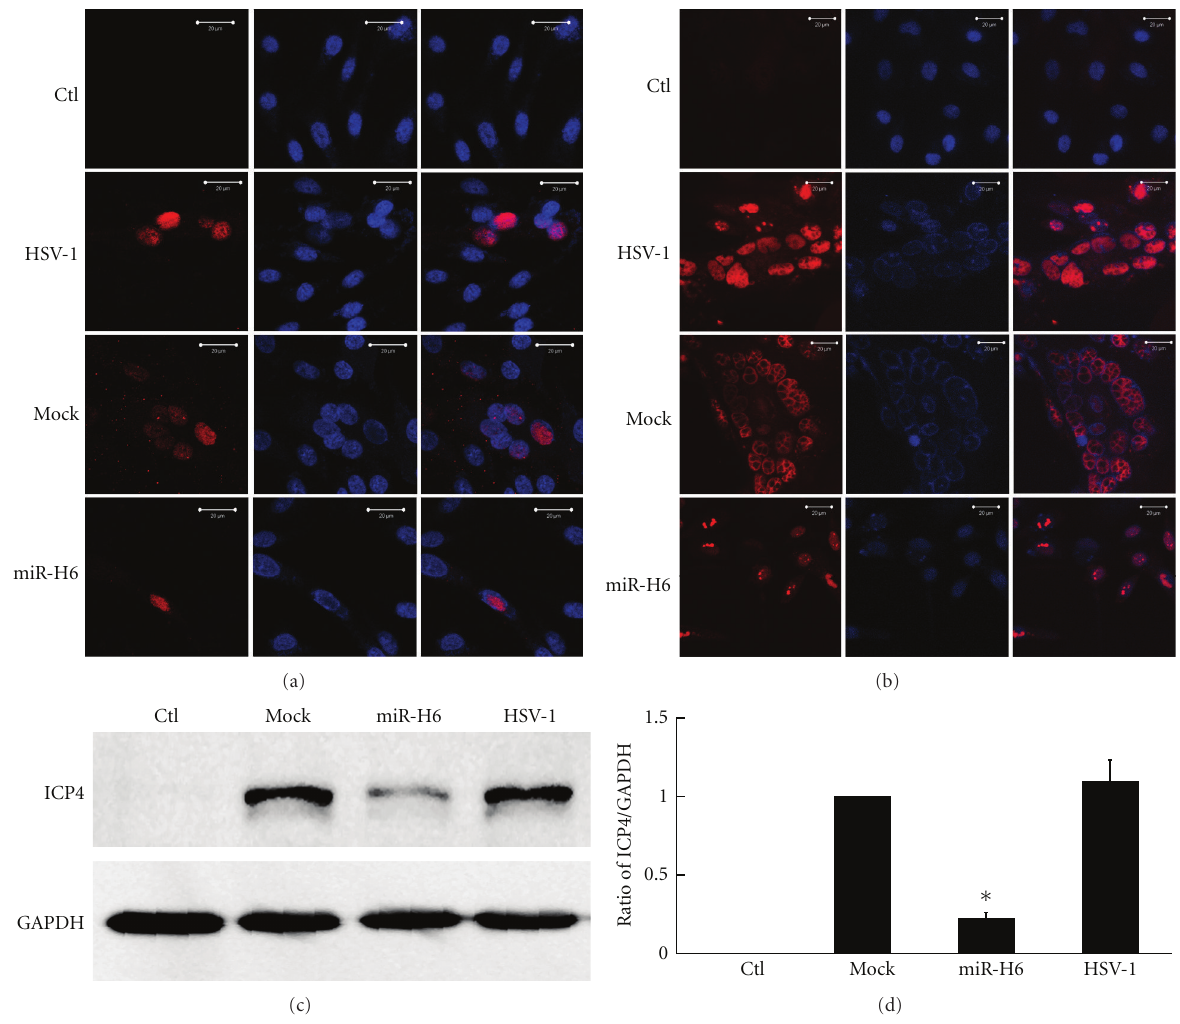
Figure 2: miR-H6 decreased ICP4 protein expression in HSV-1-infected HCE cells. HCE cells were transfected with miR-H6 mimics and mock RNA and then infected with MOI 0.1 of HSV-1 24h posttransfection. The staining of ICP4 protein in HCE cells at 12 h p.i. (a) and at 24 h p.i. (b) TRITC labeled the antibody-stained ICP4 (red, left) and the hoechst-dyed nucleus (blue, middle). Images of ICP4 and the nucleus were merged (right), scalebar: 20 μ m. (c) The ICP4 band was determined by Western blot. (d) Quantitative analysis of bands in (c). Significantly lower levels of ICP4 in HCE cells transfected with miR-H6 ( ∗ P < 0 . 05, miR-H6 versus mock or HSV-1